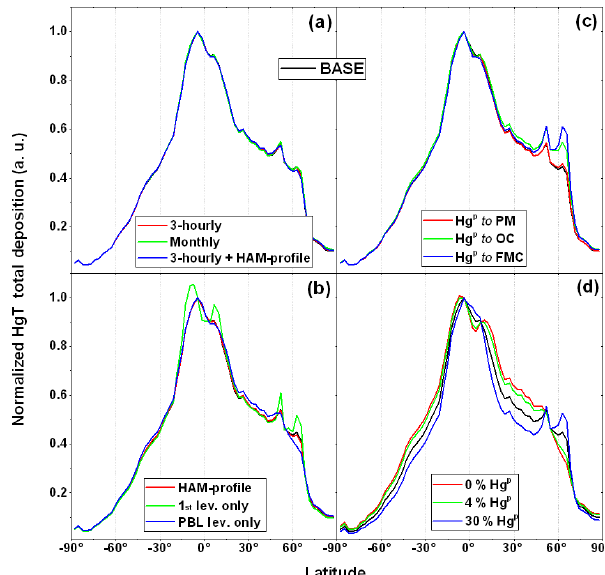
Figure 5. Latitudinal profiles of the normalised Hg total deposition from the model BASE run, compared with a selection of sensitivity runs, assuming (a–b) different emission time resolution and vertical profile, as well as a combination of both; (c) different Hg P emission geographical distributions, as well as different Hg 0 The normalisation was done by maximum.